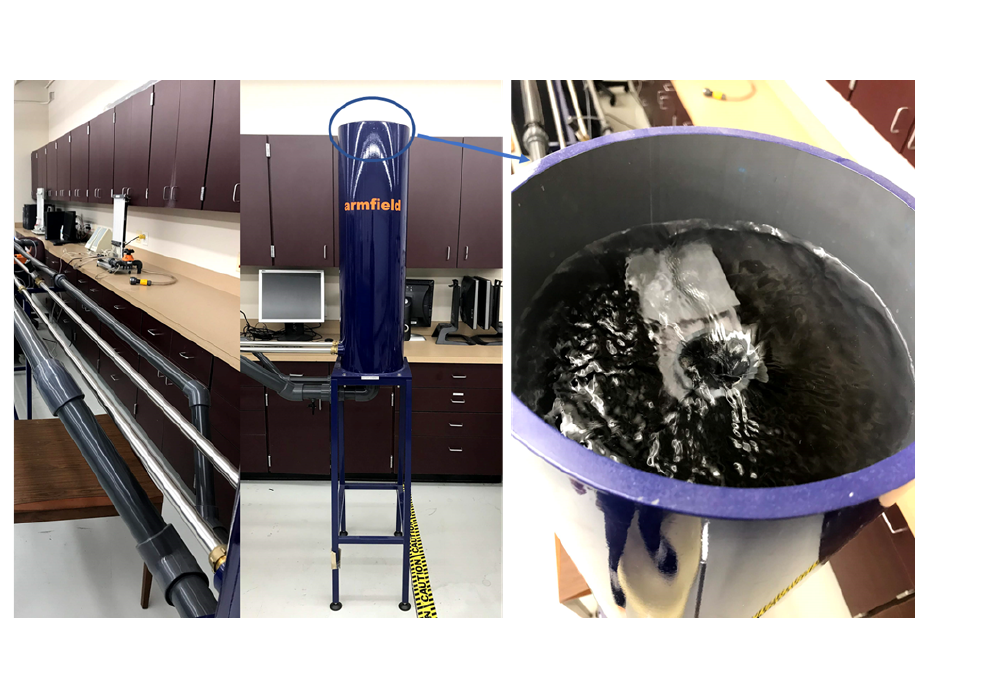
Figure 2. Laboratory water hammer system [1].